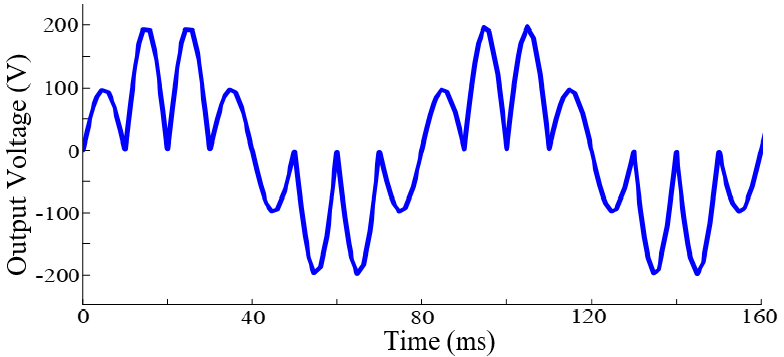
Figure 11 . Output voltage of one − fourth frequency conversion of input frequency for resistive